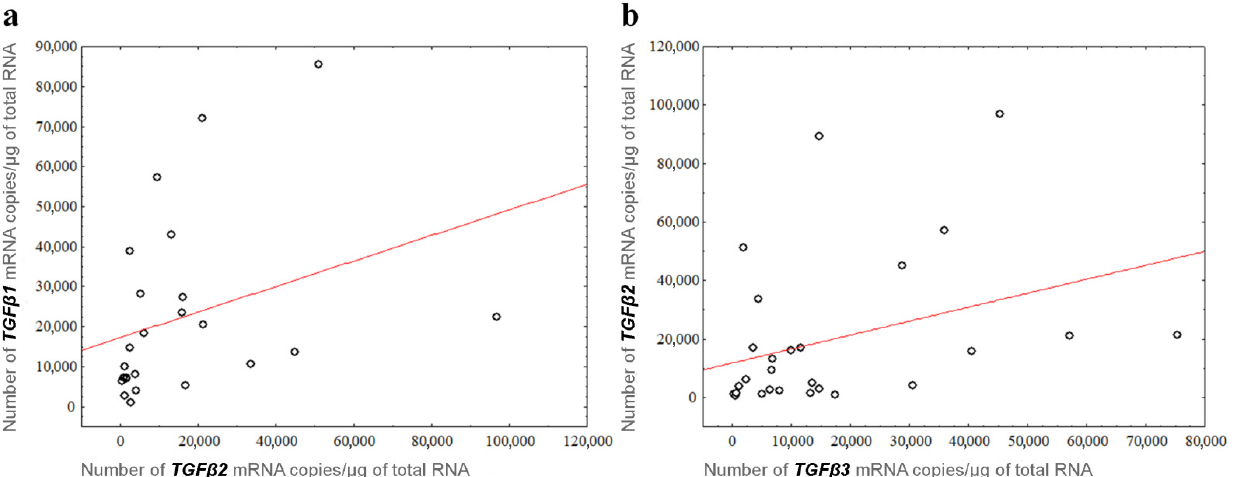
Figure 3. TGF β 2 expression is positively correlated with ( a ) TGF β 1 ( rs = 0.539130) and ( b ) TGF β 3 ( rs = 0.457265) in gliomas with G3/G4 grades of malignancy. ( r s = 0.457265) in gliomas with G3/G4 grades of